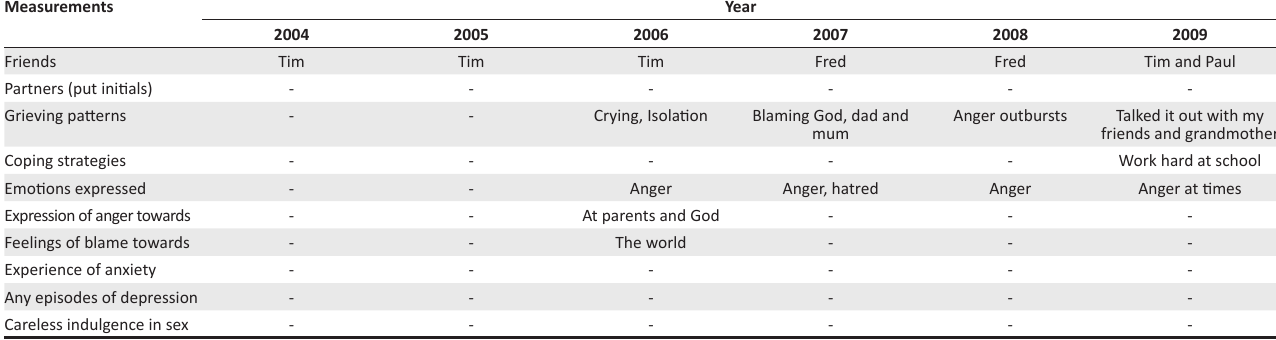
TABLE 2b: A sample of the event history calendar completed by a participant.